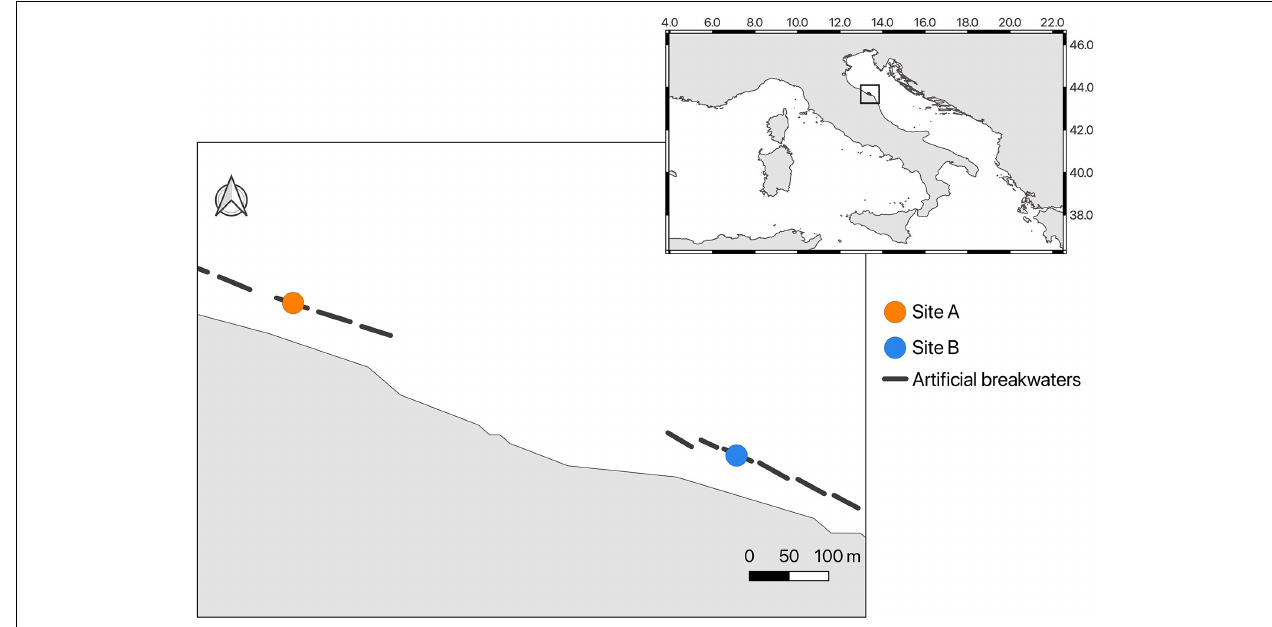
FIGURE 2 | Translocation sites A and B along the coast of Falconara Marittima (Italy, Adriatic Sea).